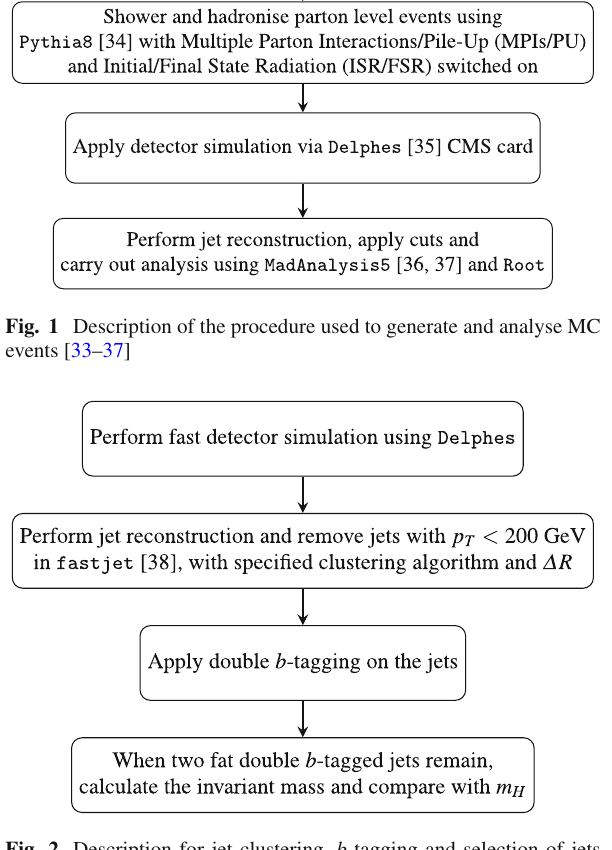
Fig. 2 Description for jet clustering, b -tagging and selection of jets